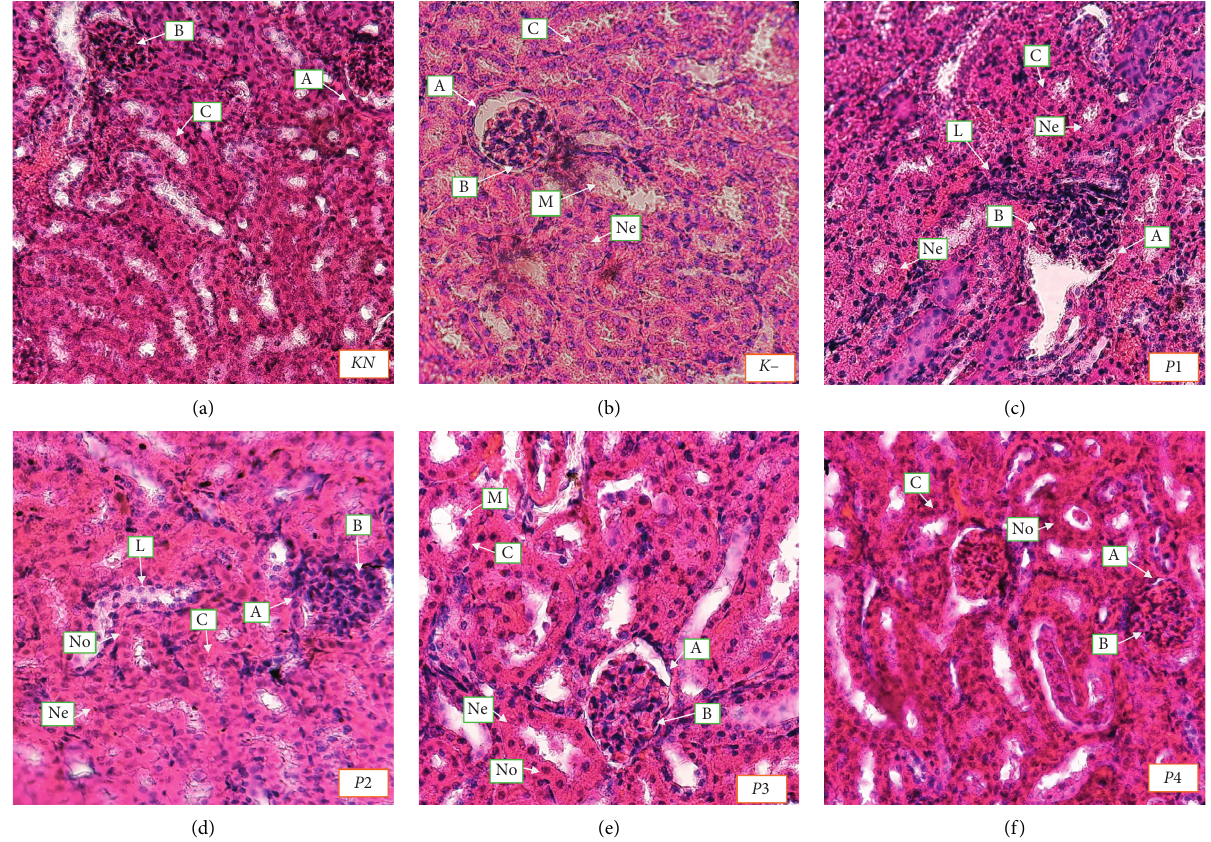
Figure 5: Histology of the kidney (40 × objectives, scale bar 50 μ m). KN : normal control, K − : negative control. P 1, P 2, P 3, and P 4 were treated with 50, 100, 200, and 400mg/kg BW methanolic extract of okra pods, respectively. A: Bowman’s capsule, B: glomerular, C: proximal tubule, Ne: necrosis cell, No: normal cell, M: macrophage, L: polymorphonuclear